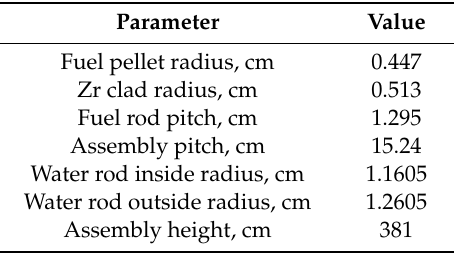
Table 1. BWR 10 × 10 assembly parameters [26].